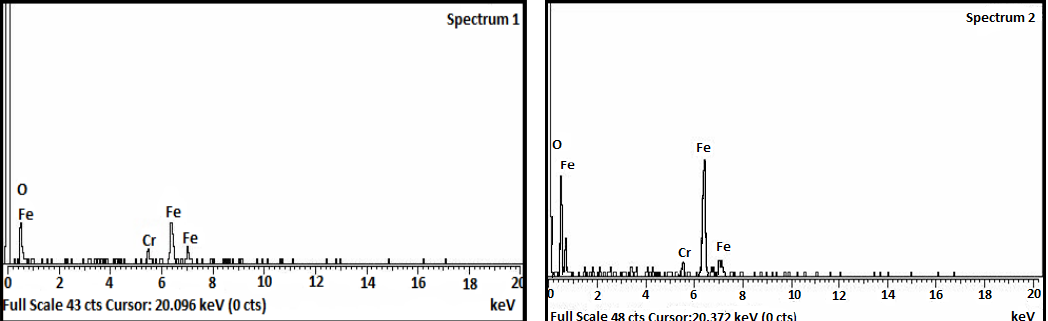
O (Spectrum 1) and nano-powder Fe 2 3